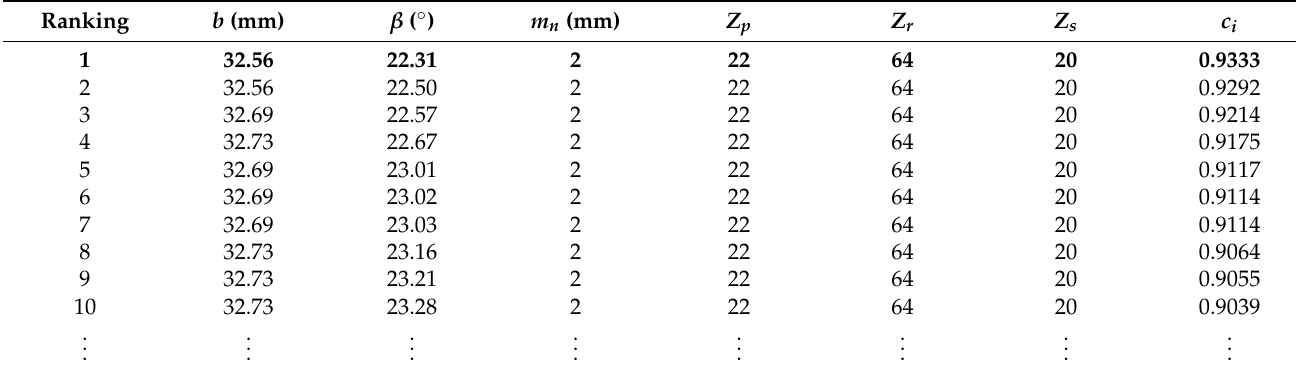
Table A3. Optimization results from MUOD (Case